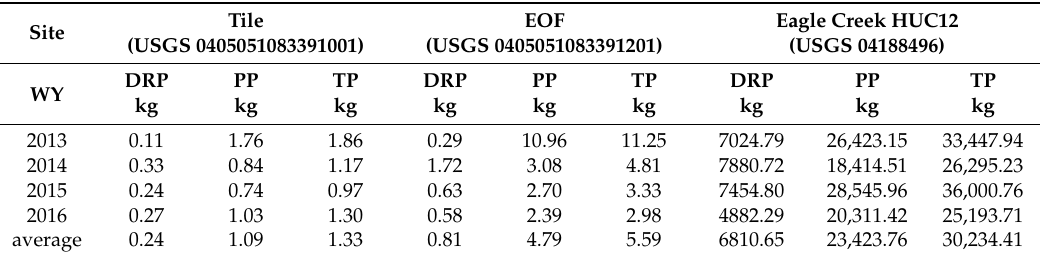
Table 10. Monitored phosphorus load contributions by site investigated with the Eagle Creek watershed, Ohio SWAT